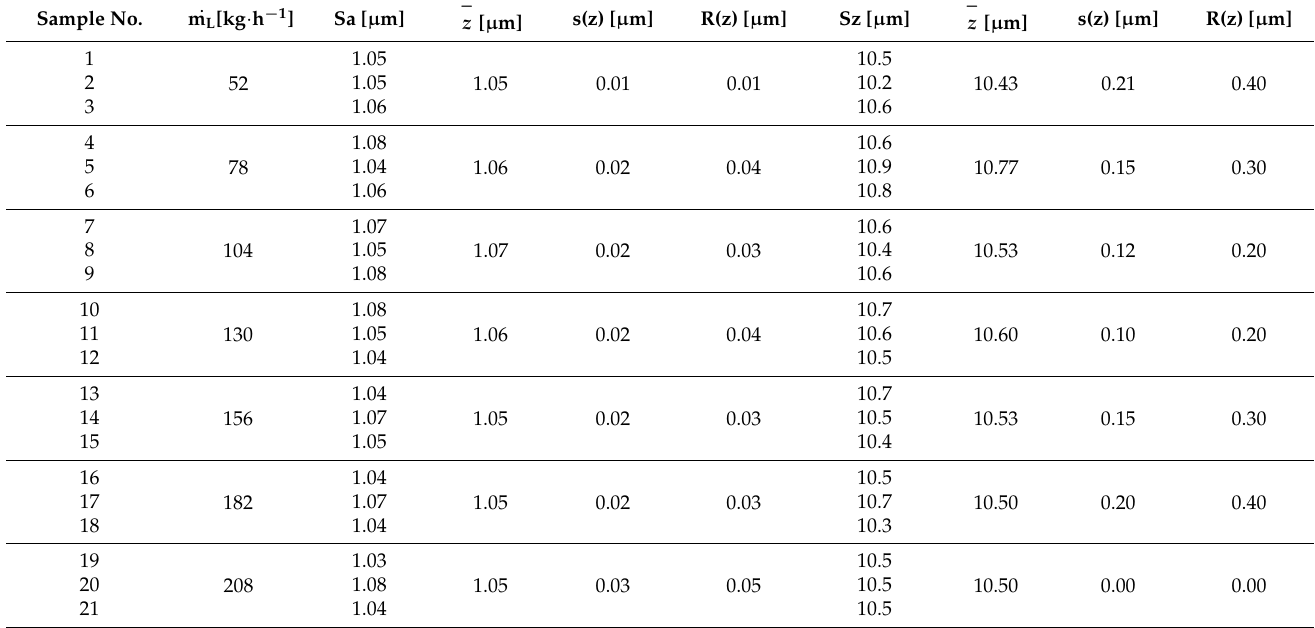
Table 8. Results of Sa and Sz measurements of PA2 aluminum alloy samples before paint coating (p w = 20 MPa, l 2 = 250 mm, κ = 90 ◦ ).